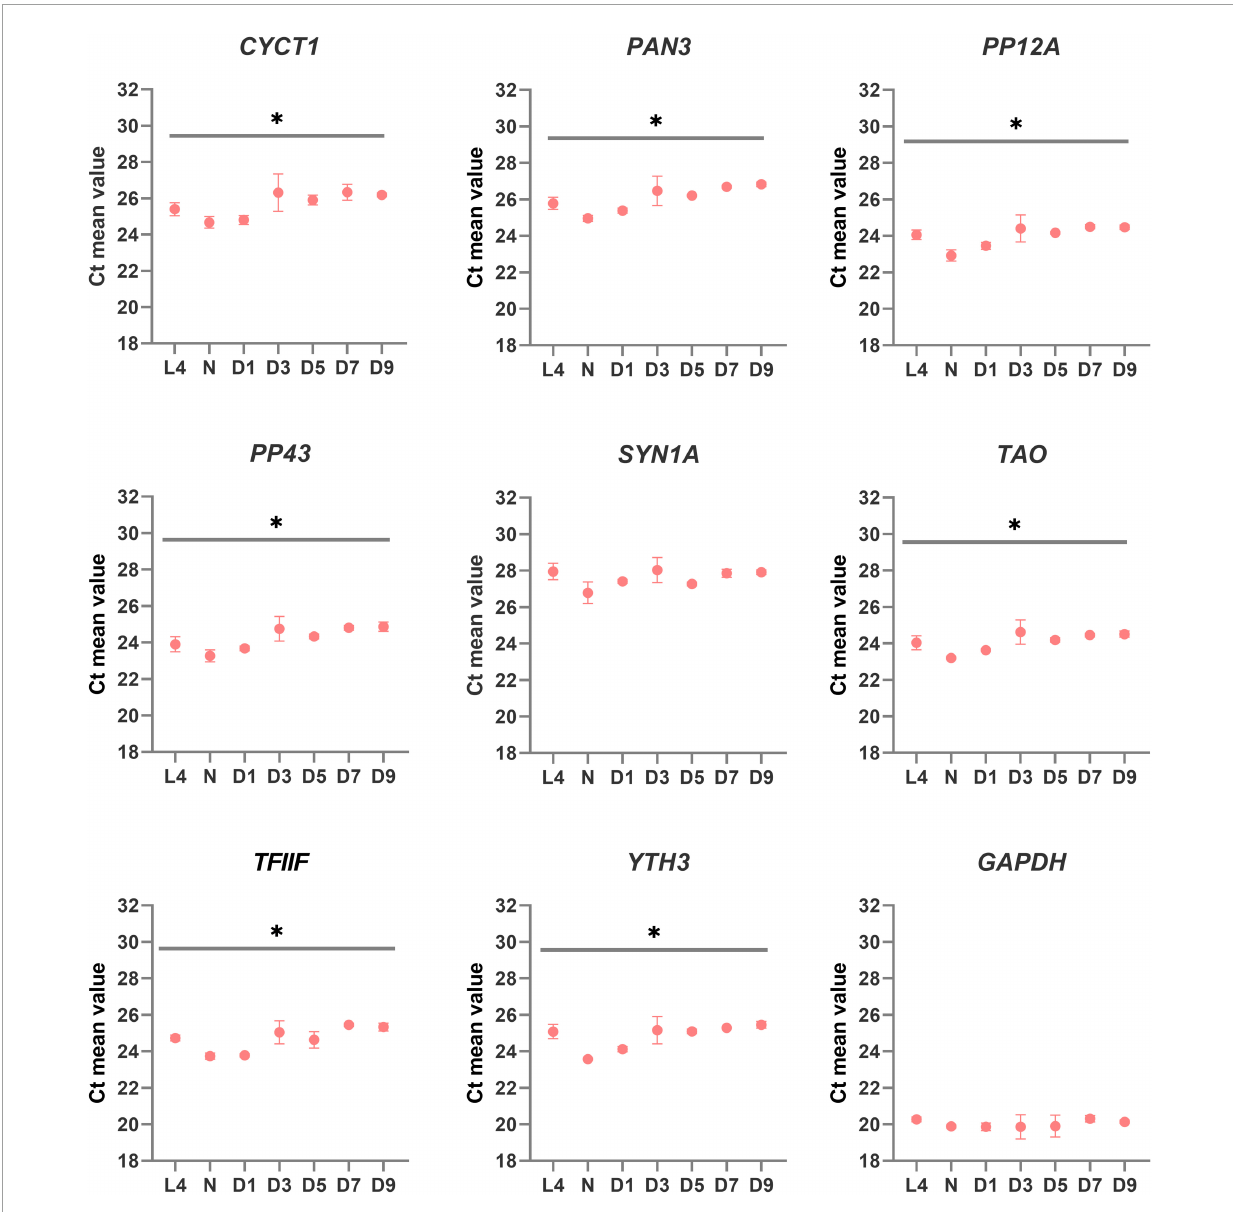
FIGURE2 Quantitative real-time PCR (qRT-PCR) expression profile of candidate reference genes in Sitophilus oryzae gut-bacteriome samples. Graphs represent the mean Ct value for each developmental stage. One-way ANOVA was performed to assess differences between the means of all developmental stages. Asterisks denote statistical significance (ANOVA with Kruskal-Wallis test, ∗ p ≤ 0.05). Error bars represent standard